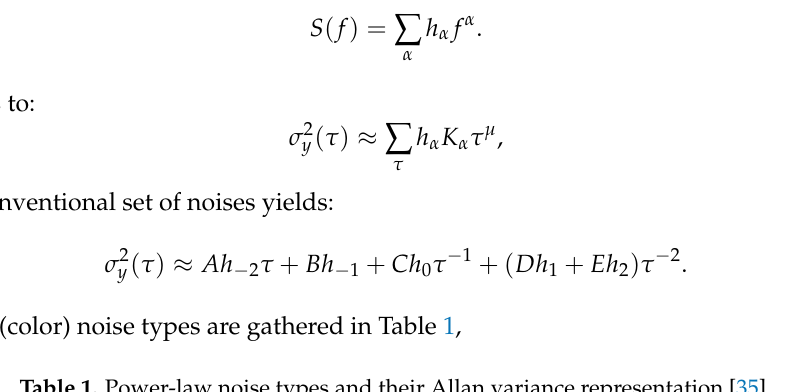
Table 1. Power-law noise types and their Allan variance representation